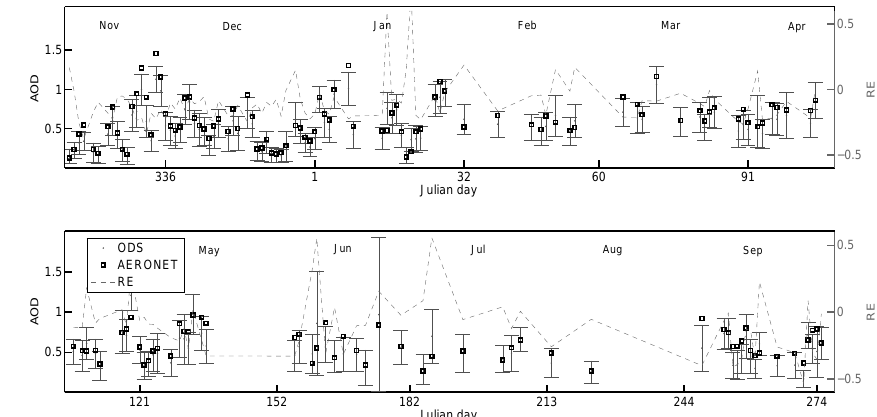
Figure 13. AOD derived from ODS blue channel (grey dots with error bars) and AERONET (squares) at 370nm between November 2004 and October 2005. The grey dashed line represents the relative error that is defined in Eq. (4).